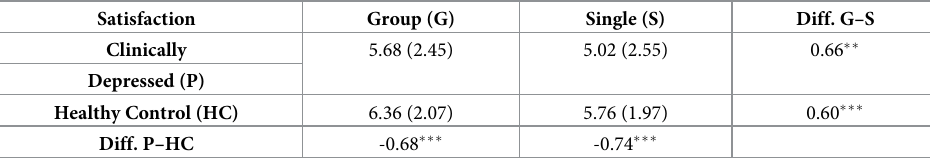
Table 13. Individual satisfaction by treatment. Satisfaction